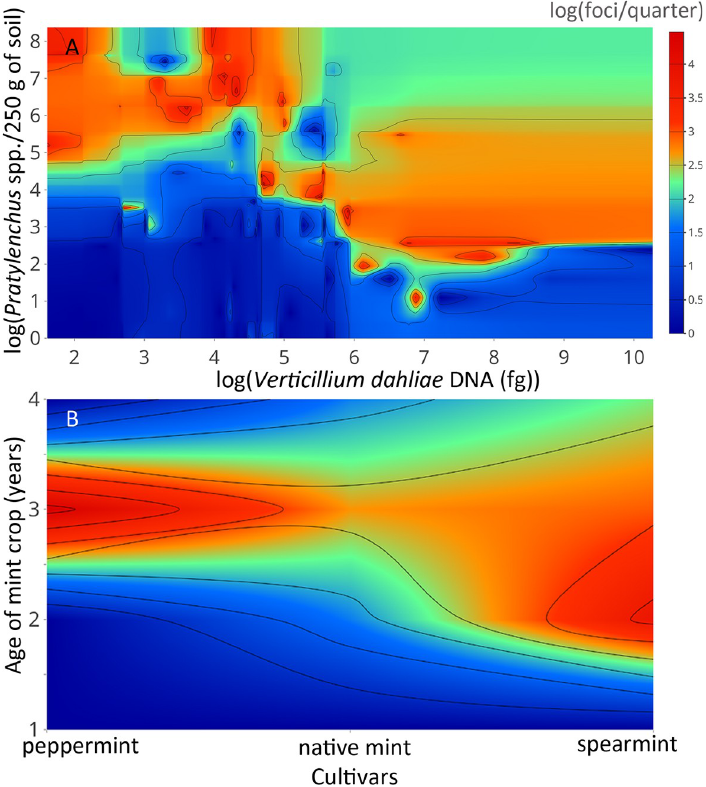
Fig 4. Wilt symptoms as a function of combined biotic and abiotic predictors. Bivariate plots illustrate the relationship between wilt and (A) Verticillium dahliae and Pratylenchus spp., and (B) mint cultivars and the age of mint crops. Wilt intensity is expressed in color where red represents severe wilt and blue represents no wilt.